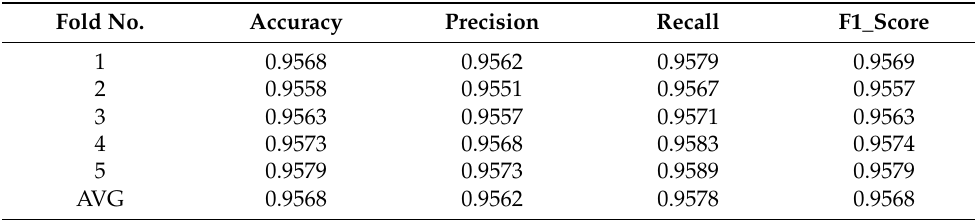
Table 5. Performance of model evaluation using the five-fold cross-validation procedure. Fold No.